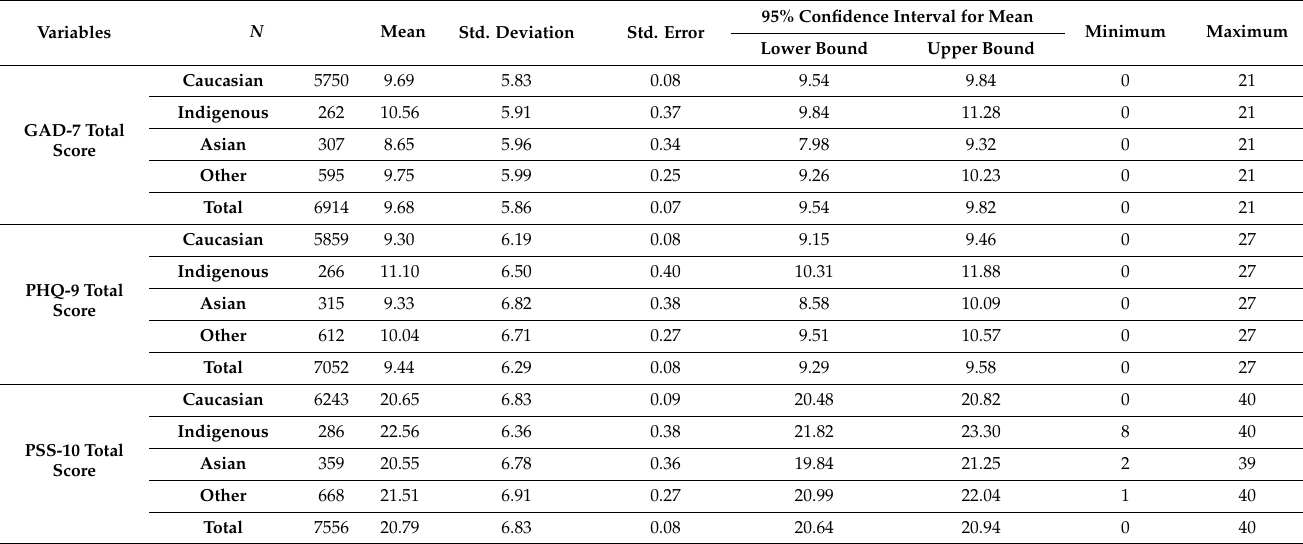
Table 3. Descriptive illustration of mean scores of GAD-7, PHQ-9 and PSS-10 scales by ethnic